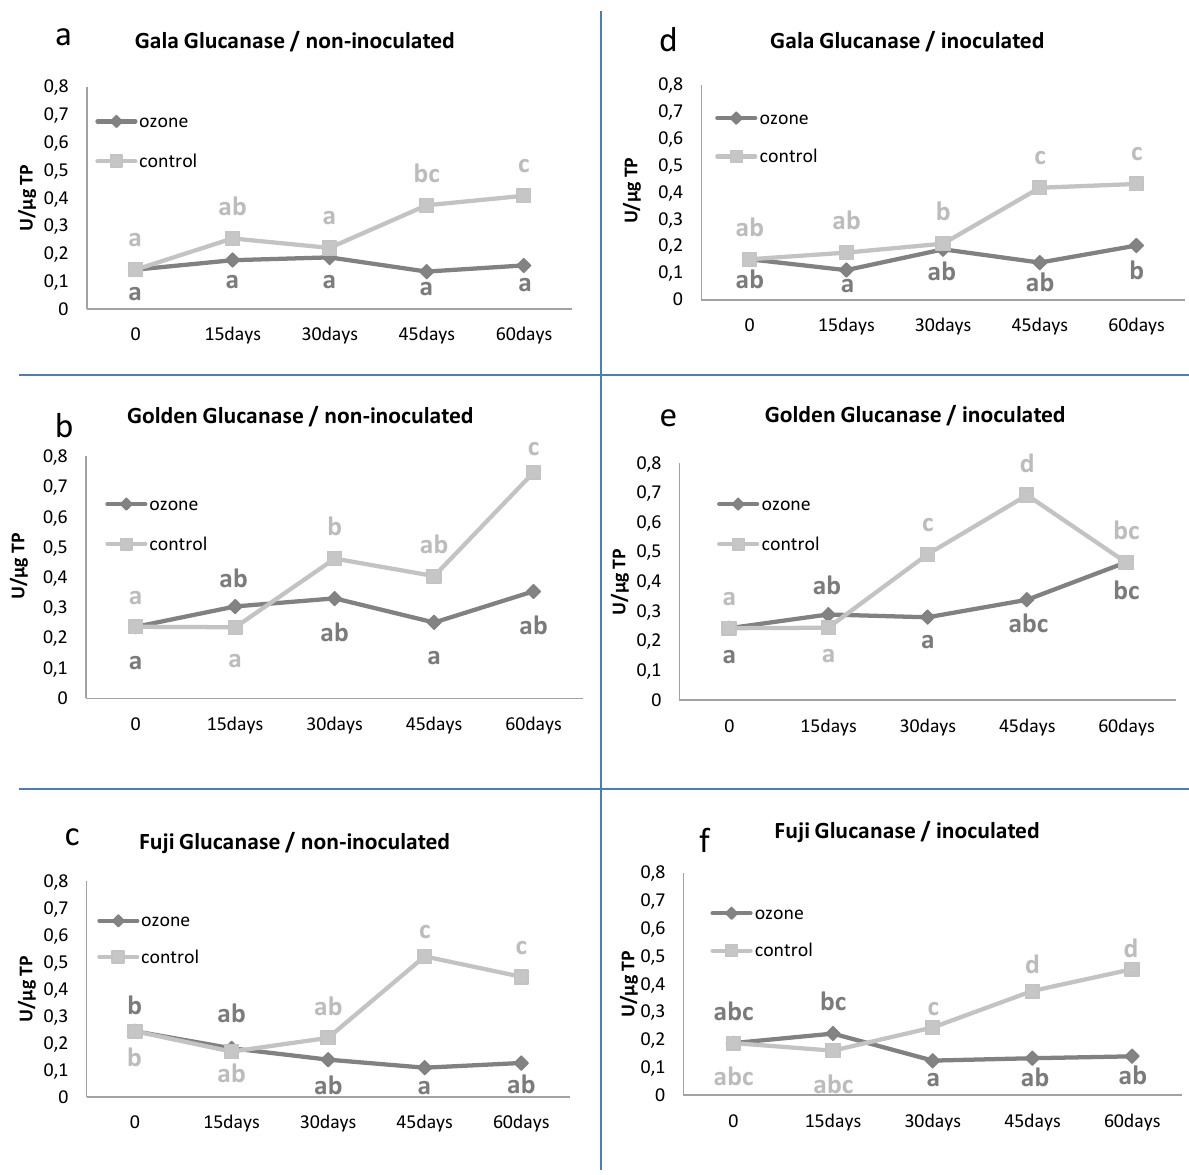
Figure 3. Mean glucanase specific activity in non-inoculated and in Penicillium expansum inoculated apple fruits (‘Royal Gala’, ‘Golden Delicious’, ‘Fuji’), either non-treated (a, b, c) or treated by ozone at 0,5 μL L -1 (d, e, f), and stored at 1°±1C in the dark. Means followed by the same letter are not significantly different (Fisher’s Least Significance Difference test (LSD, P =